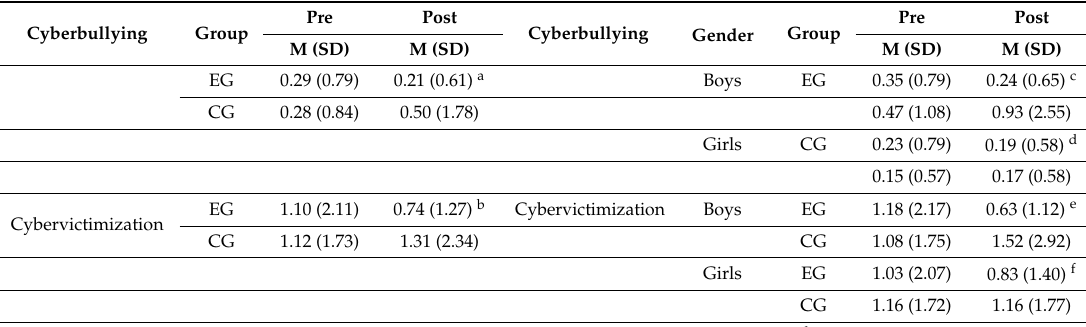
Table 2. Pre–post differences in outcome variables.